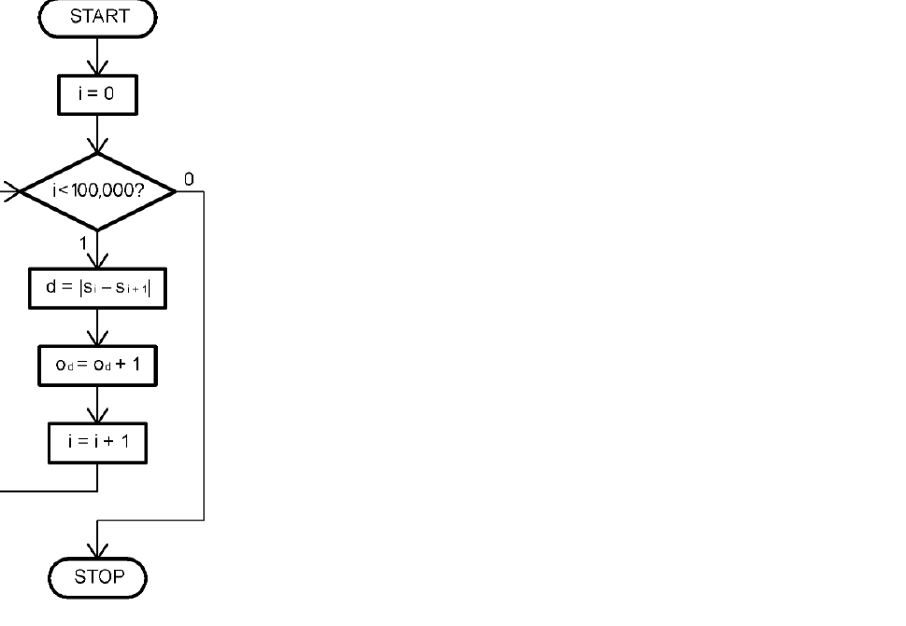
Figure 1. An algorithm of the incremental decomposition calculation [66].